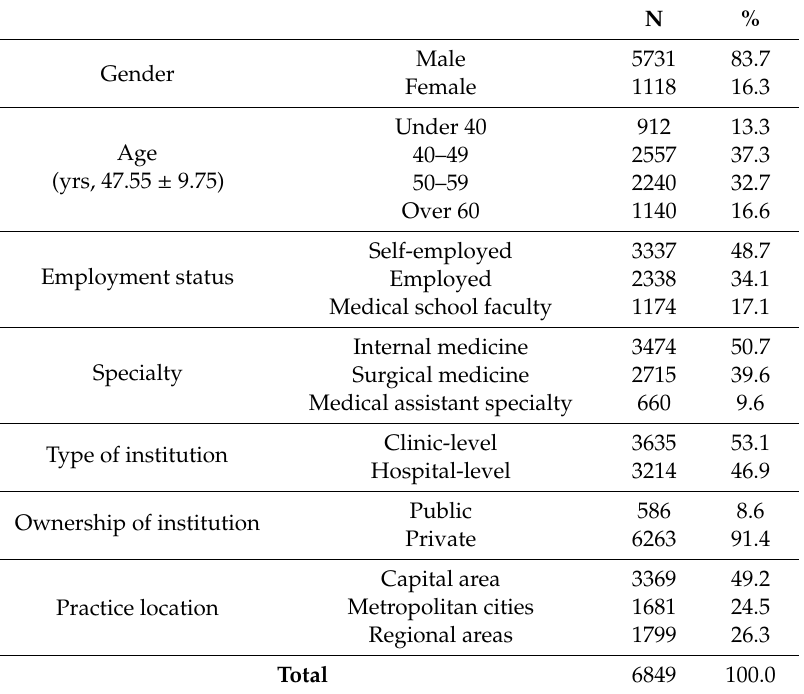
Table 1. Characteristics of